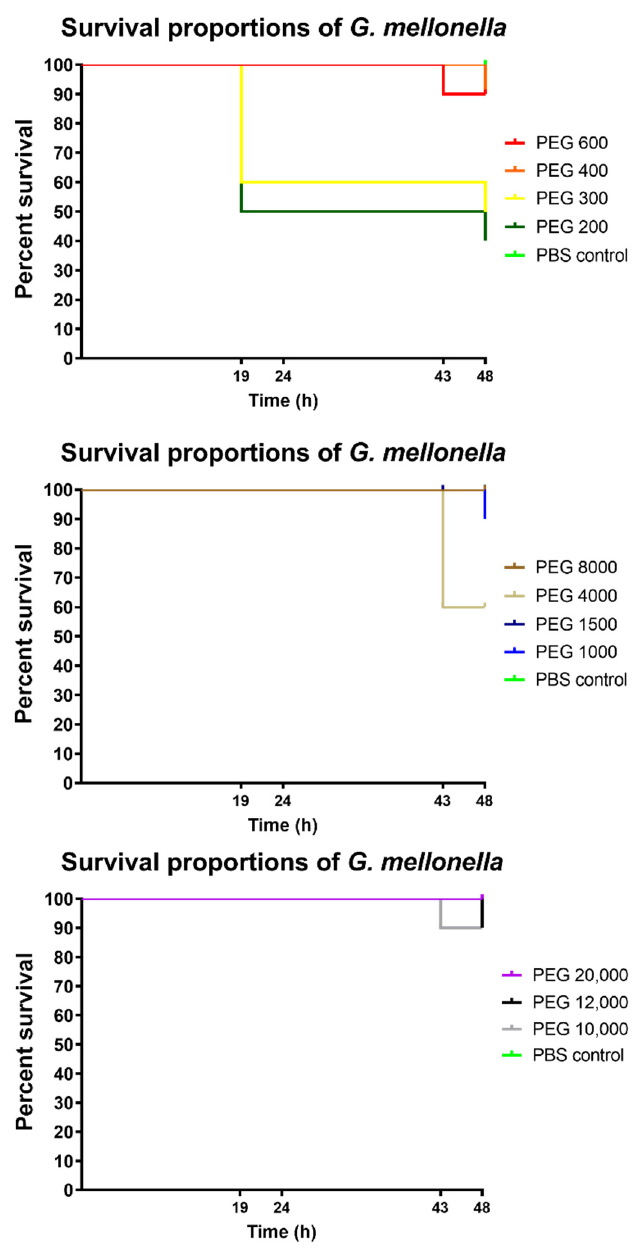
Figure 6. Kaplan–Meier survival curves of G. mellonella larvae. Each group consisted of 10 specimens, who were injected with 20 µ L of test samples. The following death events occurred during the experiment: 19 h: PEG 200: 5 (top), PEG 300: 4 (top); 43 h: PEG 600: 1 (top), PEG 4000: 4 (middle), PEG 10,000: 1 (bottom); 48 h: PEG 200: 1 (top), PEG 300: 1 (top), PEG 400: 1 (top), PEG 1000: 1 (middle) PEG 12,000: 1 (bottom). Significance of treated groups compared to PBS control according to Mantel–Cox log-rank test, and Gehan–Breslow–Wilcoxon test: PEG 200: **/** (top); PEG 300: */* (top); and PEG 4000: */* (middle); all others were insignificant.